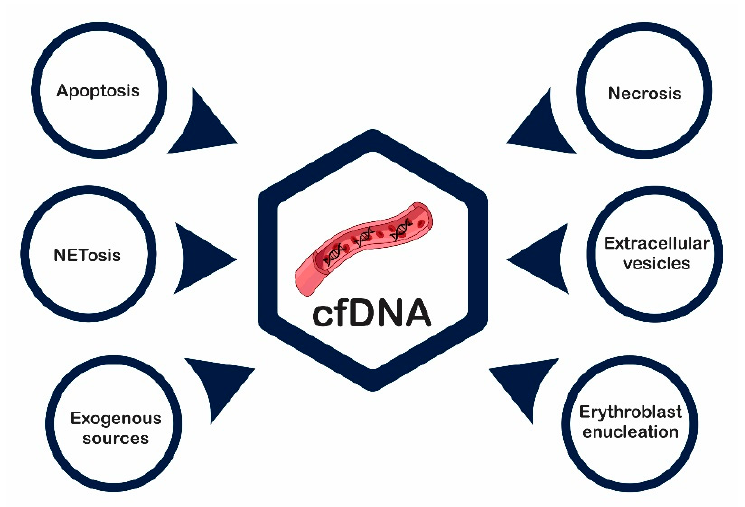
Figure 2. cfDNA sources. cfDNA is released into the human blood circulation by normal cells and cells involved with pathologic processes, including cell death. cfDNA: circulating cell-free DNA.